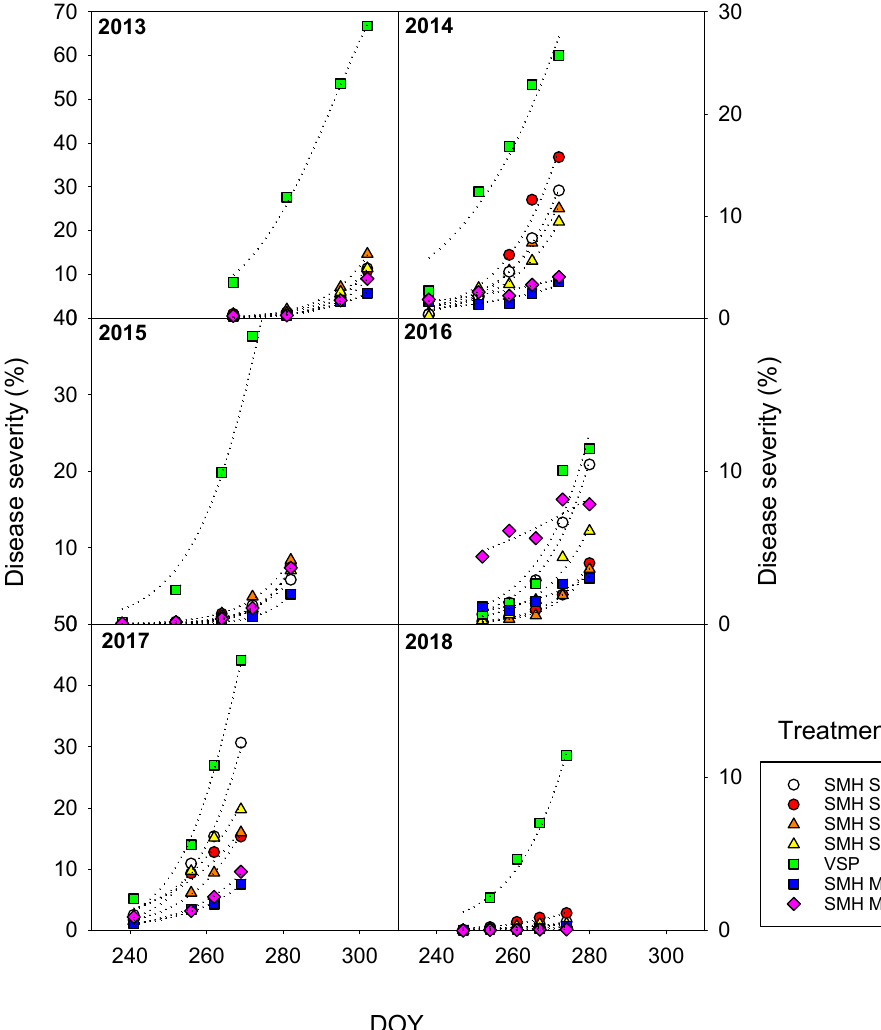
Figure 2. Progress of the disease severity of Botrytis cinerea in the different treatments between 2013 and 2018 as functions of the assessment date (day of the year (DOY)). Plot symbols represent the observed disease severities, with lines showing the calculated progress according to the sigmoidal equation type y = 100/(1 + e − ((x-x 0 )/b) ). SMPH, semi-minimal pruned hedge; ST, shoot topping; VSP, vertical shoot positioning; MT, mechanical thinning.